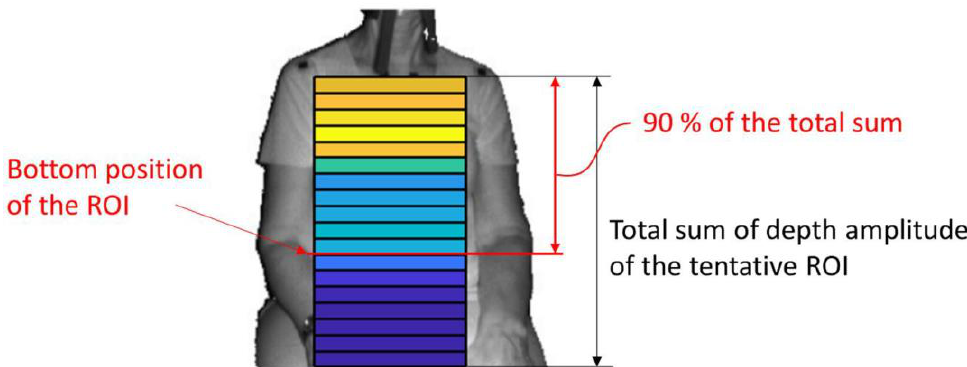
Figure 5. Determination of the final region of interest (ROI) as a selection of subregions. The areas are color coded with their corresponding amplitude strength from orange (strong) to blue (weak).